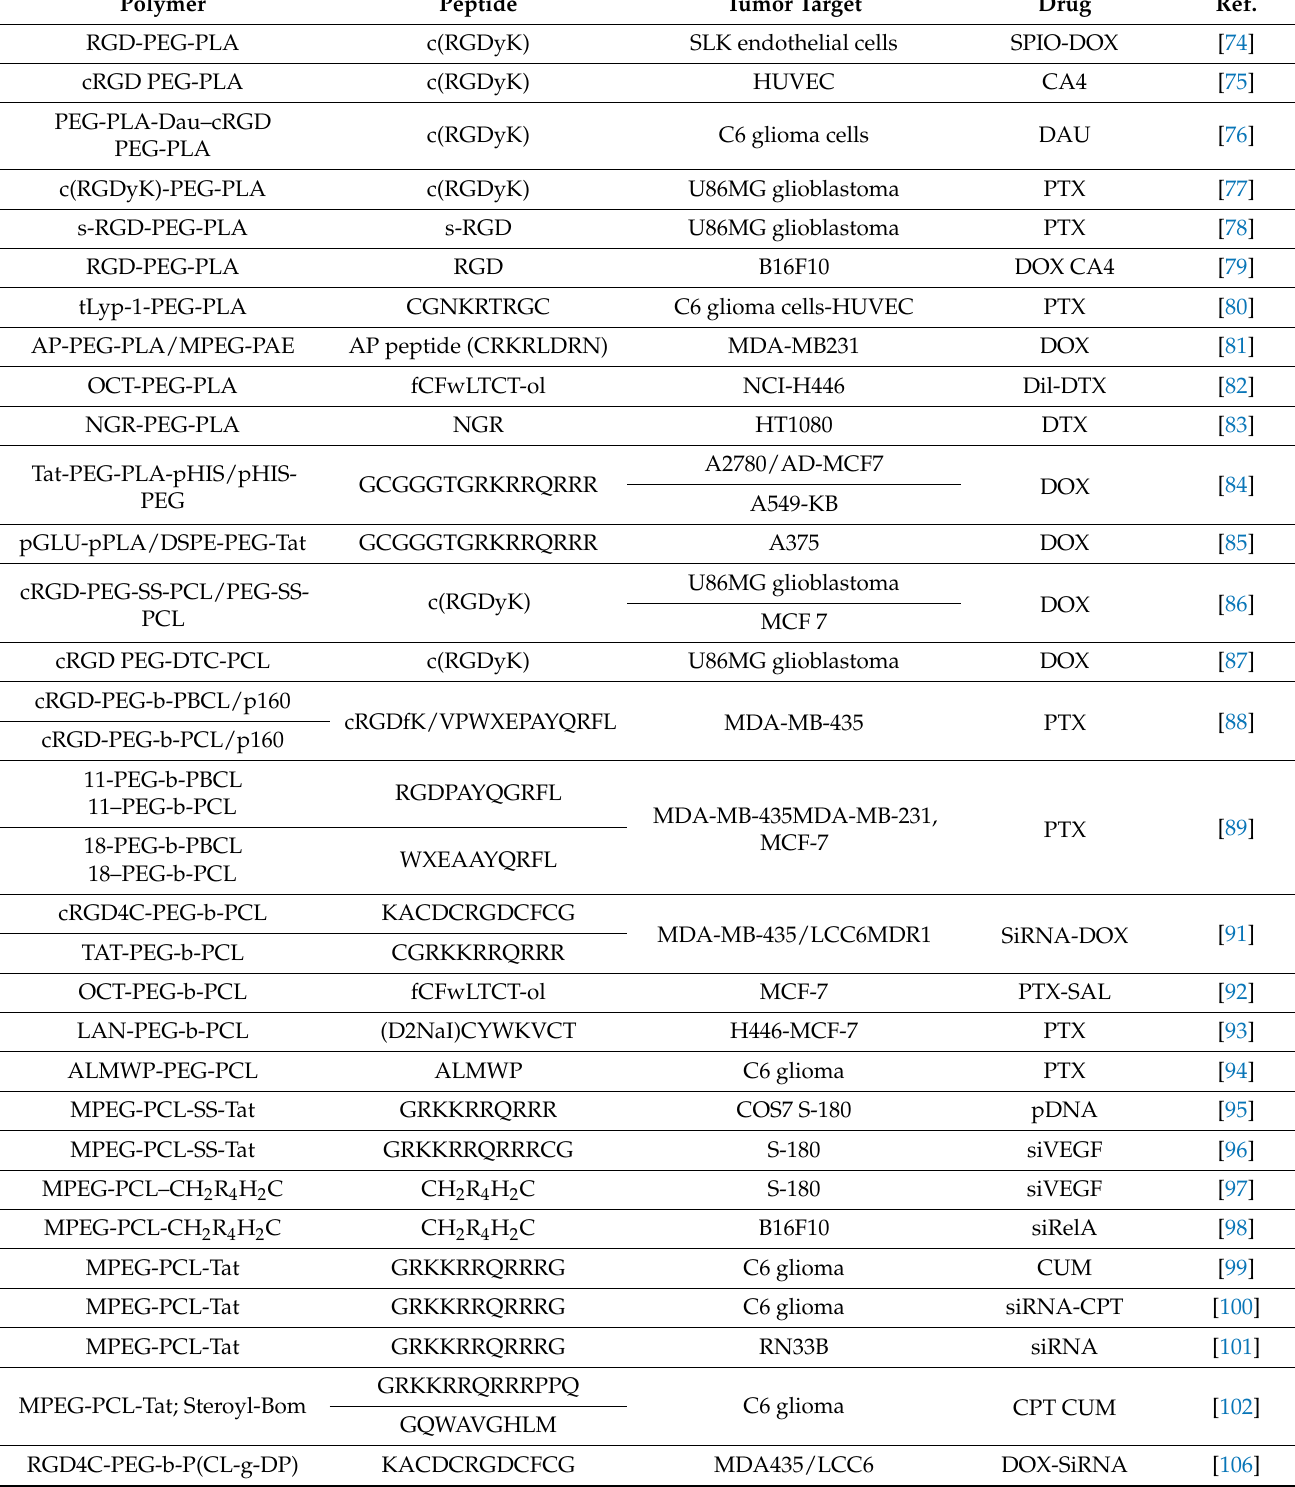
Table 2. Polymeric